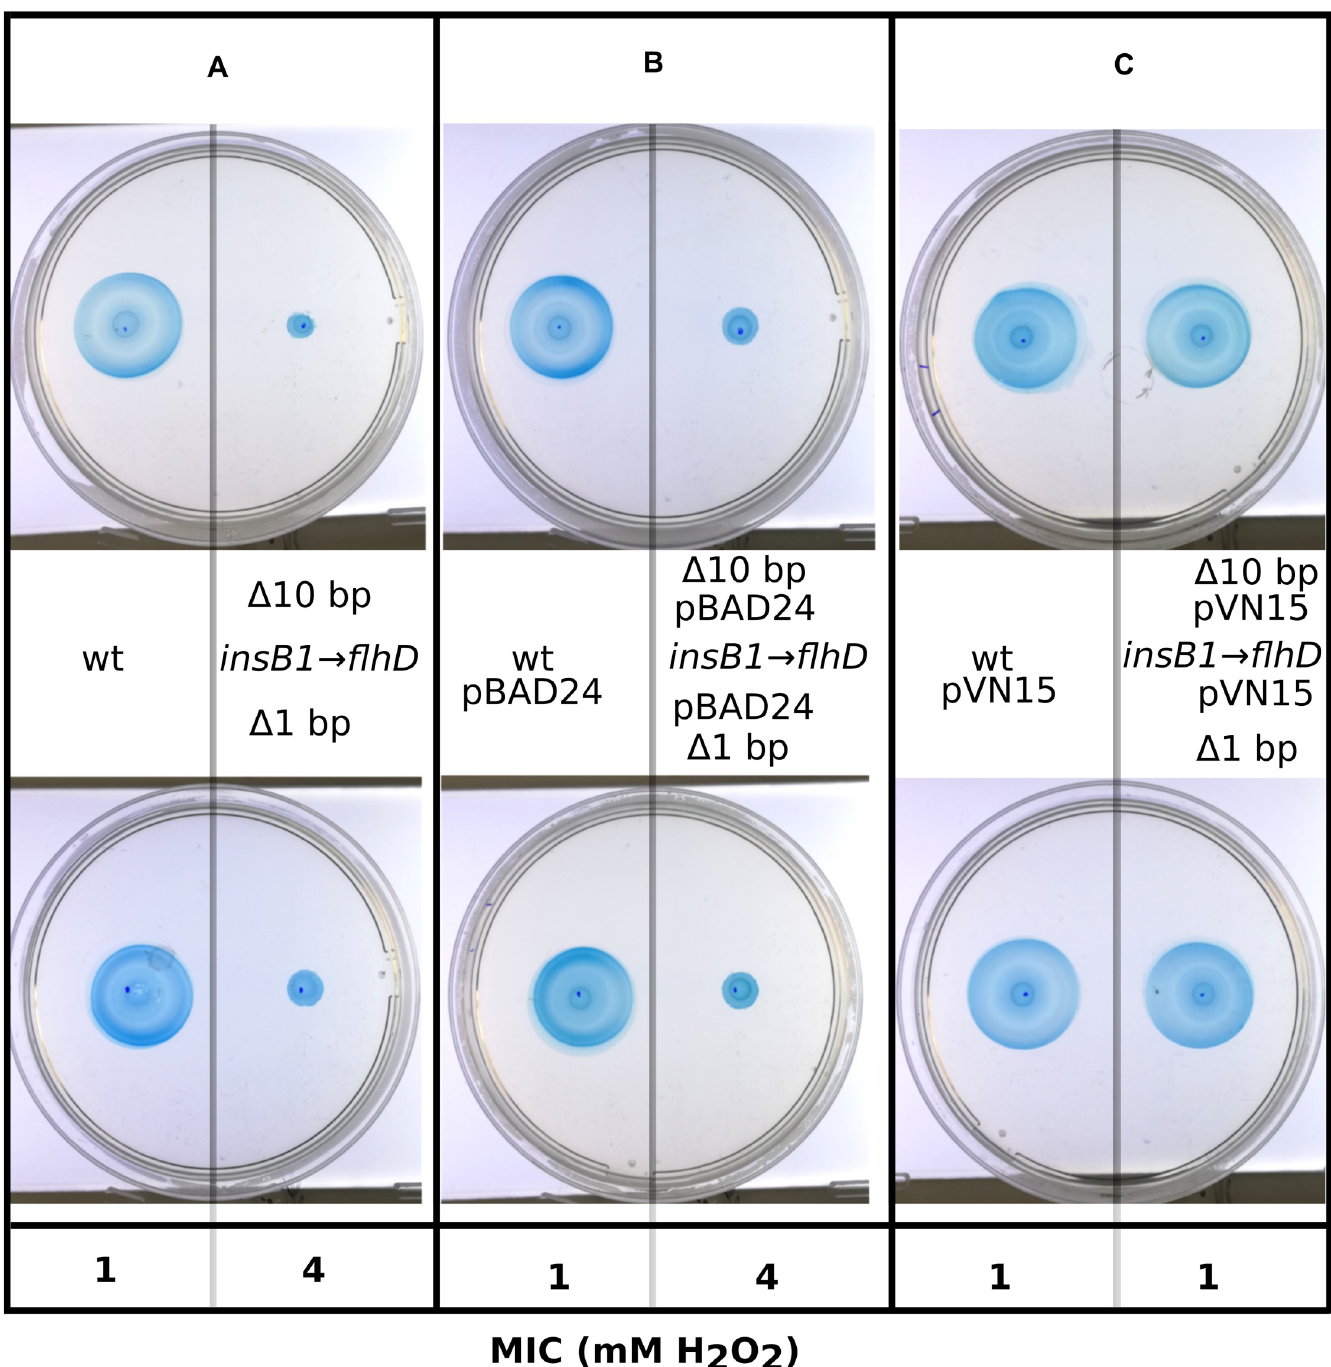
Fig 10. Motility test of E . coli MG1655 and its derivative mutants in the intergenic region between insB1 and flhD (insB1 ! flhD , positions 1978493 nt, Δ 10bp and 1978504 nt, Δ 1 bp). Panel A shows the initial phenotypes of insB1 ! flhD mutants , low motility and resistance to 4 mM H 2 O 2 while the parental strain is motile with a MIC of 4 mM H 2 O 2 . A complementation experiment showed identical phenotypes when the strains were transformed with the cloning vector (panel B) and recovery of motility and original resistance to 1 mM H 2 O 2 when both mutants are transformed with the plasmid overexpressing the operon flhDC [80] (panel C).